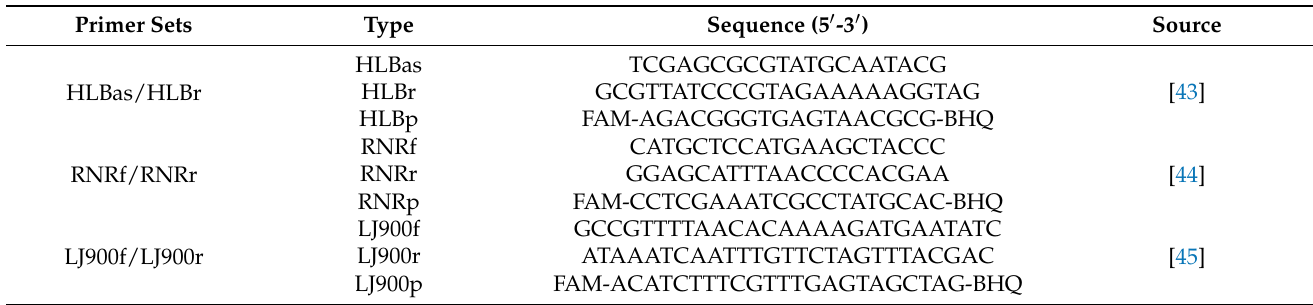
Table 1. Sequence of qPCR